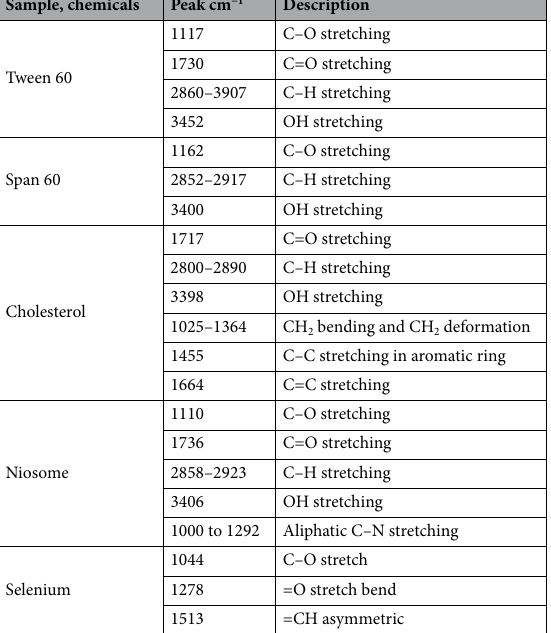
Table 4. The main characteristic peaks for FT-IR spectra of different samples/chemicals.